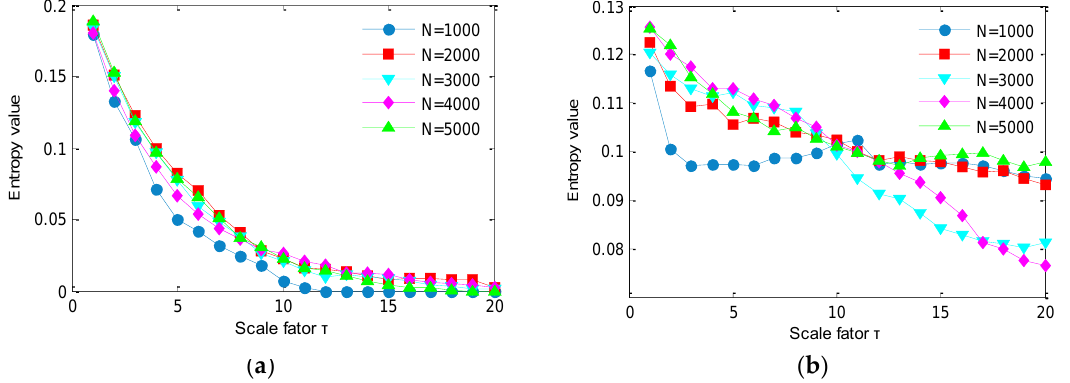
Figure 6. IMSDE of two noises for different data length: ( a ) IMSDE of white noise and ( b ) IMSDE of 1/f noise.